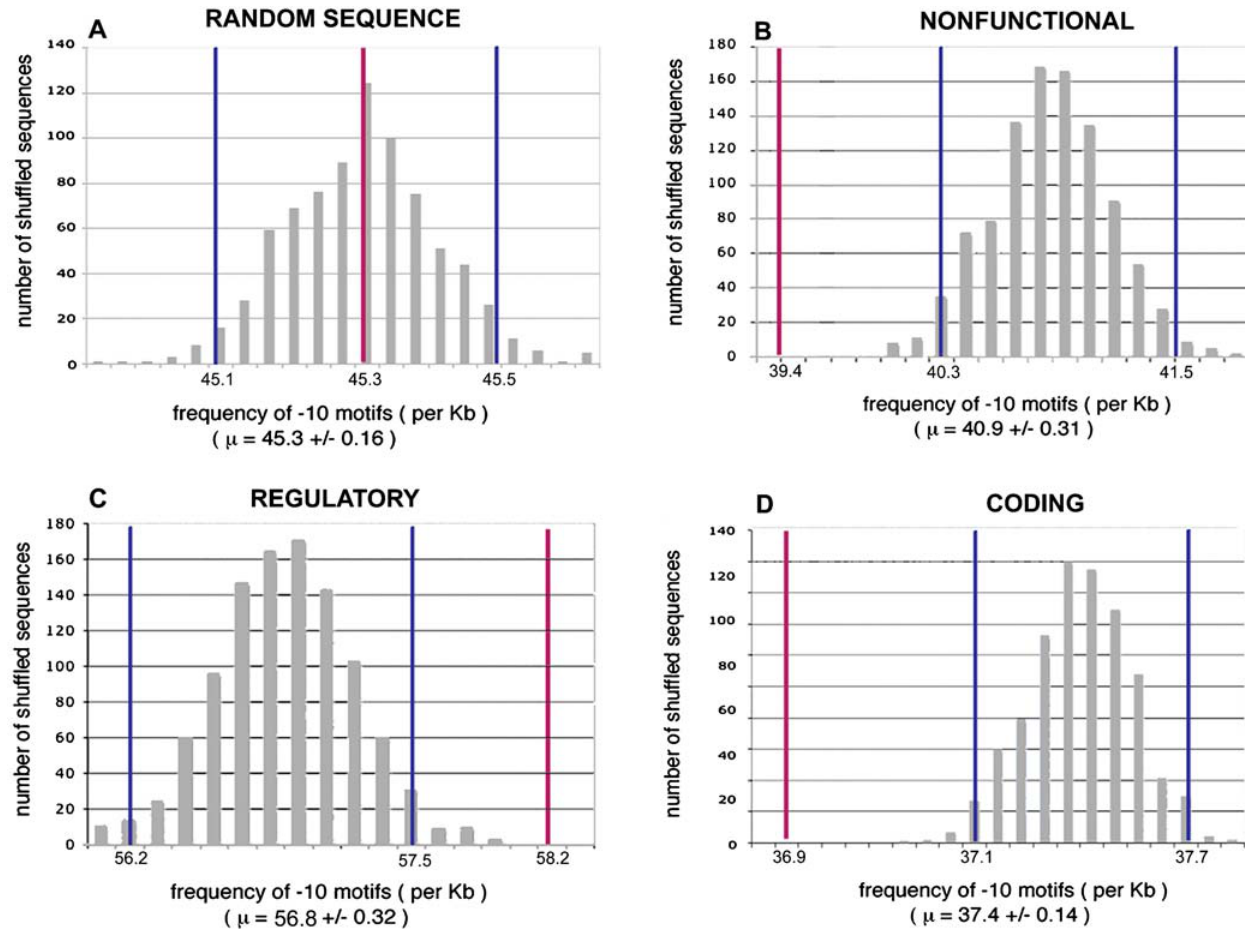
Figure 1. Comparison of observed and expected 2 10 motif frequencies in different genomic regions of E.coli. Distributions were obtained by counting and summing the occurrences of 185 2 10 hexamers in sets of 1000 shuffled sequences. This procedure was performed independently for (A) randomly generated, (B) nonfunctional, (C) regulatory, and (D) coding sequences. In each panel, the blue lines represent 6 2 Standard Deviations (SD) from the mean value in the population of shuffled sequences and the red line represents the observed count in the unshuffled E. coli